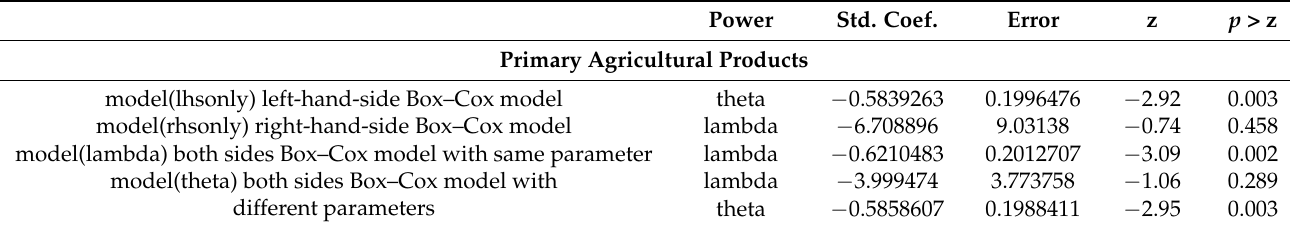
Table 4. Powers for Box–Cox